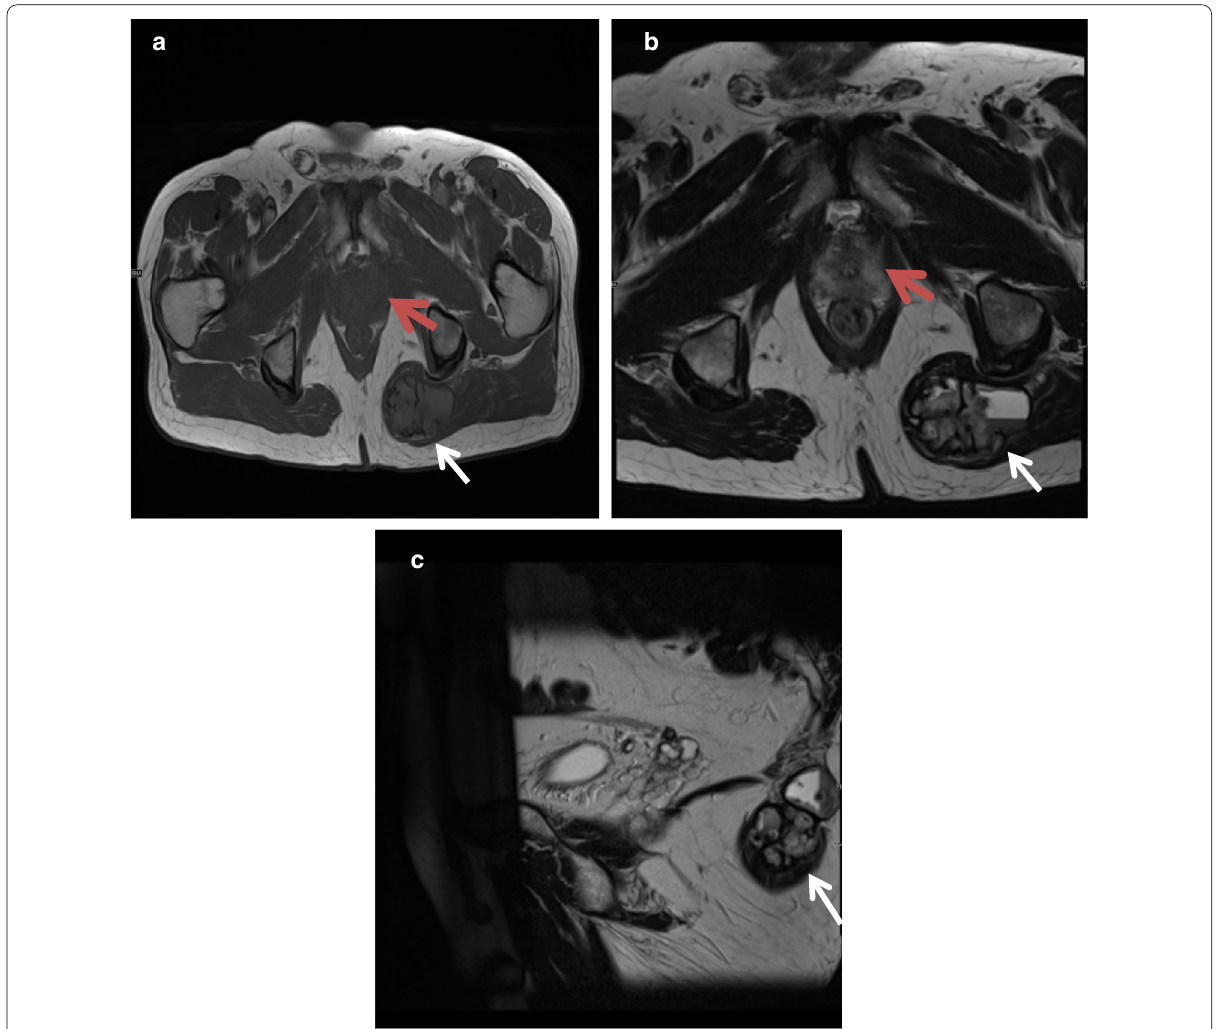
Fig. 15 Parachordoma a Axial T1-weighted, ( b ) axial T2-weighted and ( c ) sagittal T2-weighted images show a lobulated mass within the left gluteus maximus (white arrow). The prostate is labelled by the red arrow. The lesion is iso- to mildly hyperintense to muscle on T1 and hyperintense to muscle on T2 and shows internal fluid–fluid levels in keeping with haemorrhage and cystic change. The lesion did not show diffusion restriction. Surgical resection confirmed myoepithelial carcinoma or